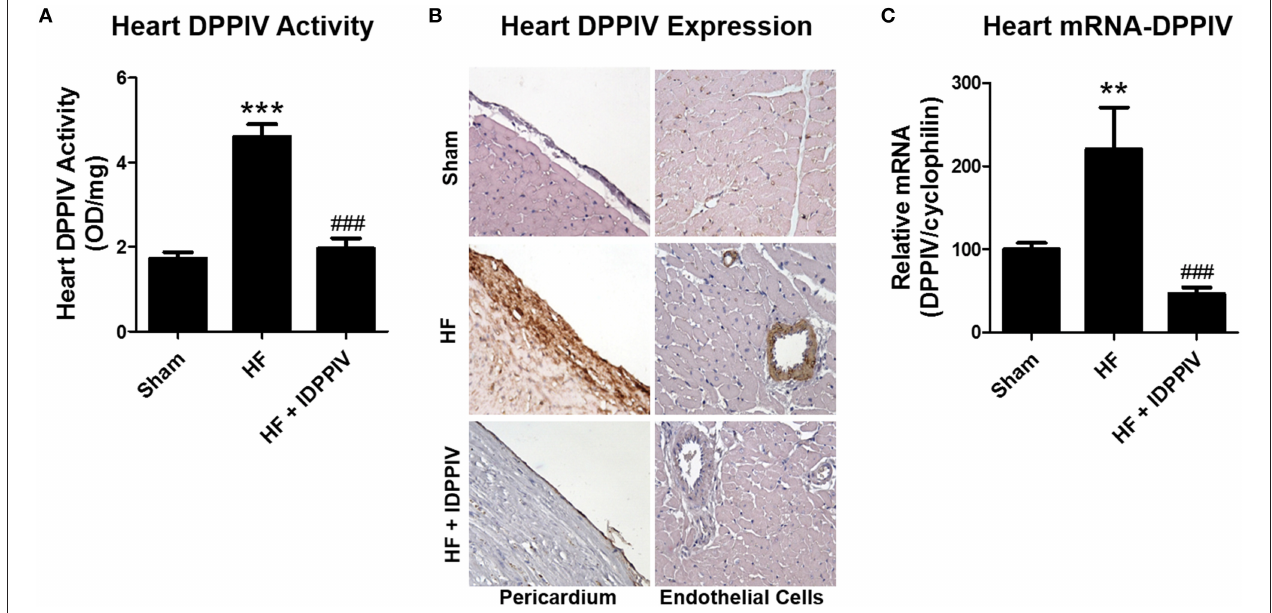
FIGURE 3 | Heart DPPIV activity and expression in sham and HF rats treated with the DPPIV inhibitor vildagliptin or with the vehicle. (A) Heart DPPIV activity was measured in sham and HF rats treated with vehicle (HF) or vildagliptin (HF + IDPPIV) by colorimetry. (B) Representative immunohistochemical staining of DPPIV in the heart (400 × original magnification). (C) Graphical representation of the relative gene expression of DPPIV in the heart of sham and HF rats treated with vildagliptin or with the vehicle. The levels of mRNA of DPPIV were measured by real-time PCR and cyclophilin used as an internal control. Values are means ± SEM. ** p < 0.01 and *** p < 0.001 vs. Sham. ### p < 0.001 vs.